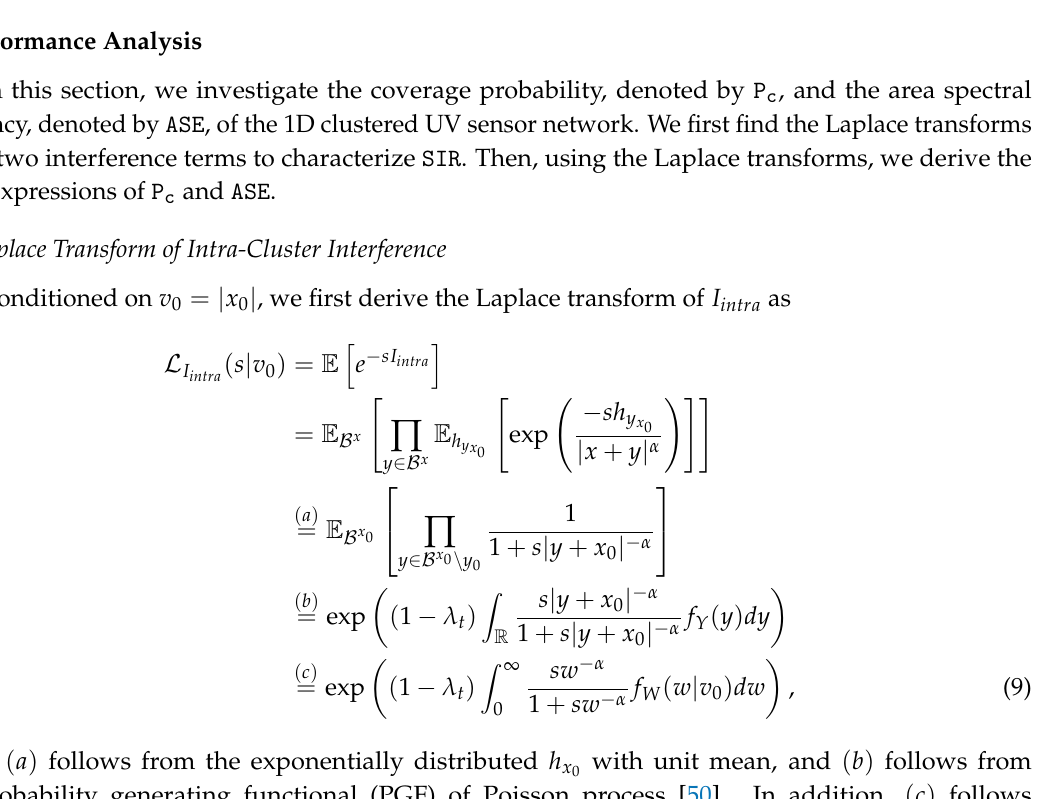
Figure 2. Example PDFs with σ =